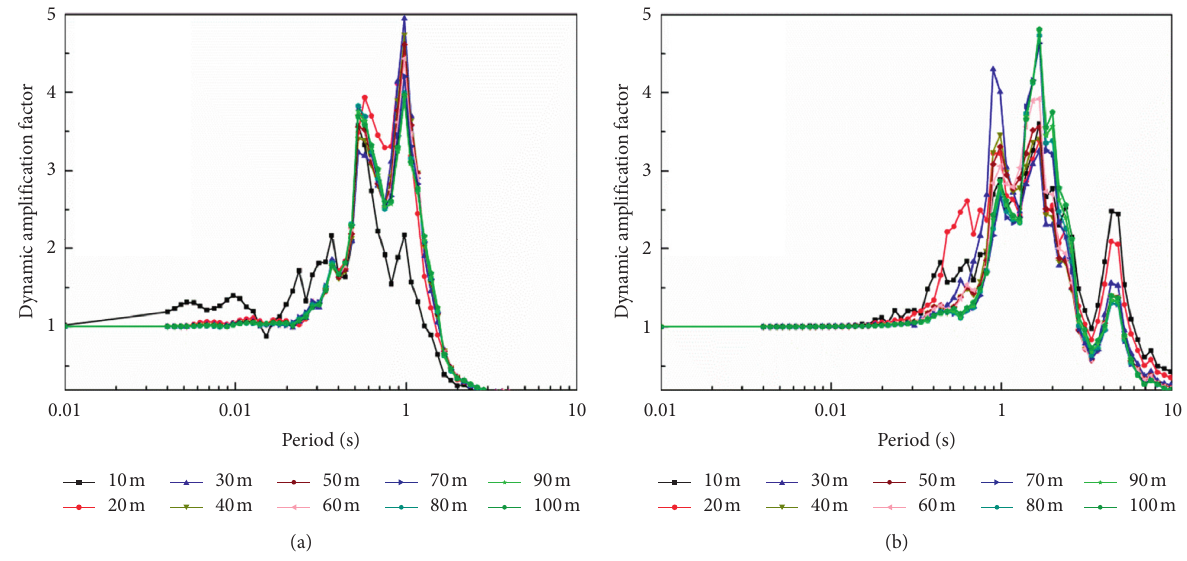
Figure 8: Acceleration spectra under the earthquake excitations. (a) Minxian seismic motion. (b) Tianshui seismic